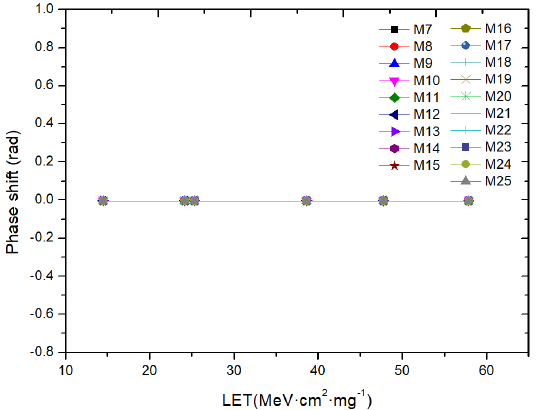
Figure 11. INP output of the RHBD FD2 for the phase shift results.